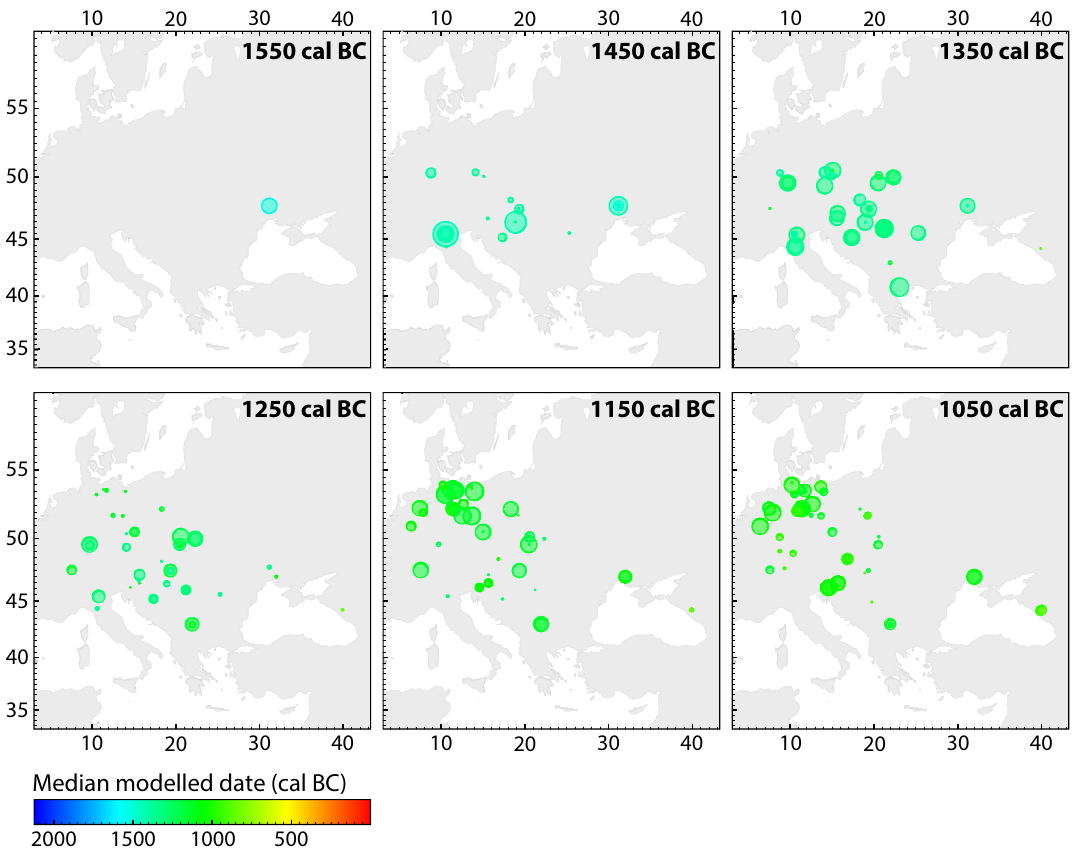
Figure 4. Time-slices of modelled dates of broomcorn millet grains, at 100-year intervals. Symbol size corresponds to the relative probability that a sample is of the date shown. Symbol colour corresponds to the median date of the sample (see